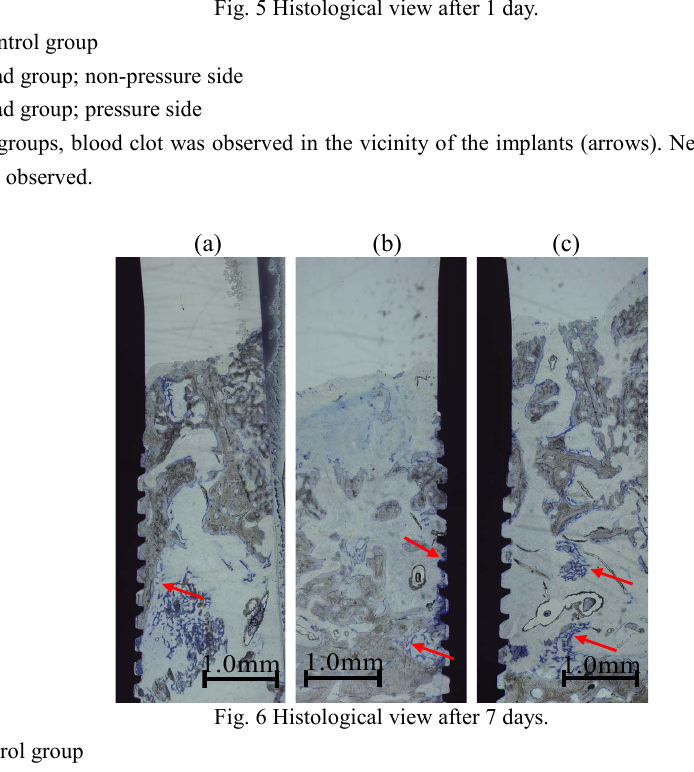
Fig. 5 Histological view after 1 day.